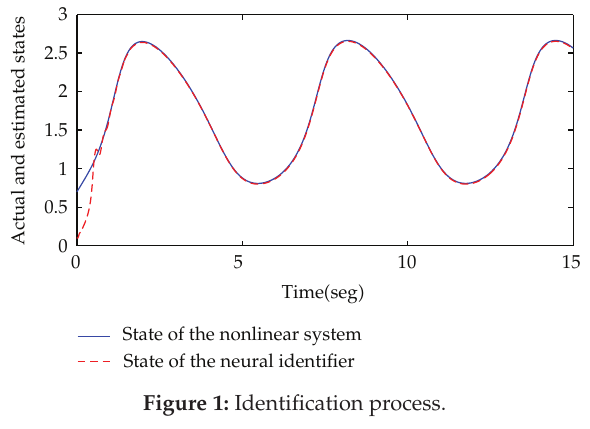
Figure 1: Identification process.